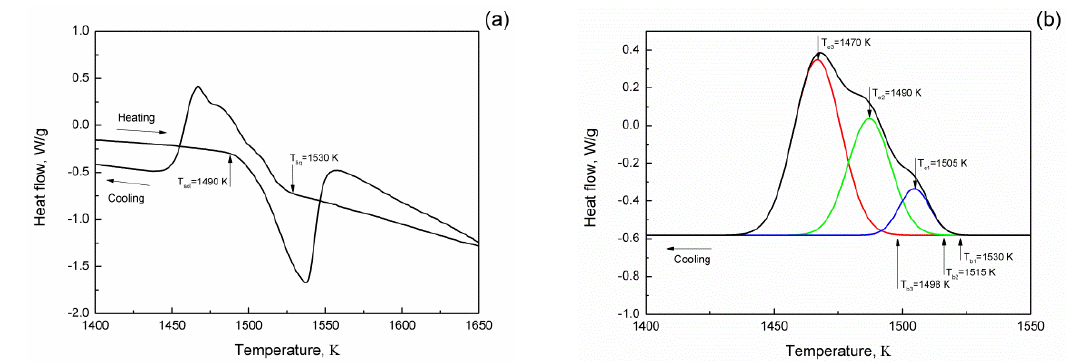
Figure 2. DTA curves ( a ) and crystallisation peak analysis ( b ) of the investigated alloy.